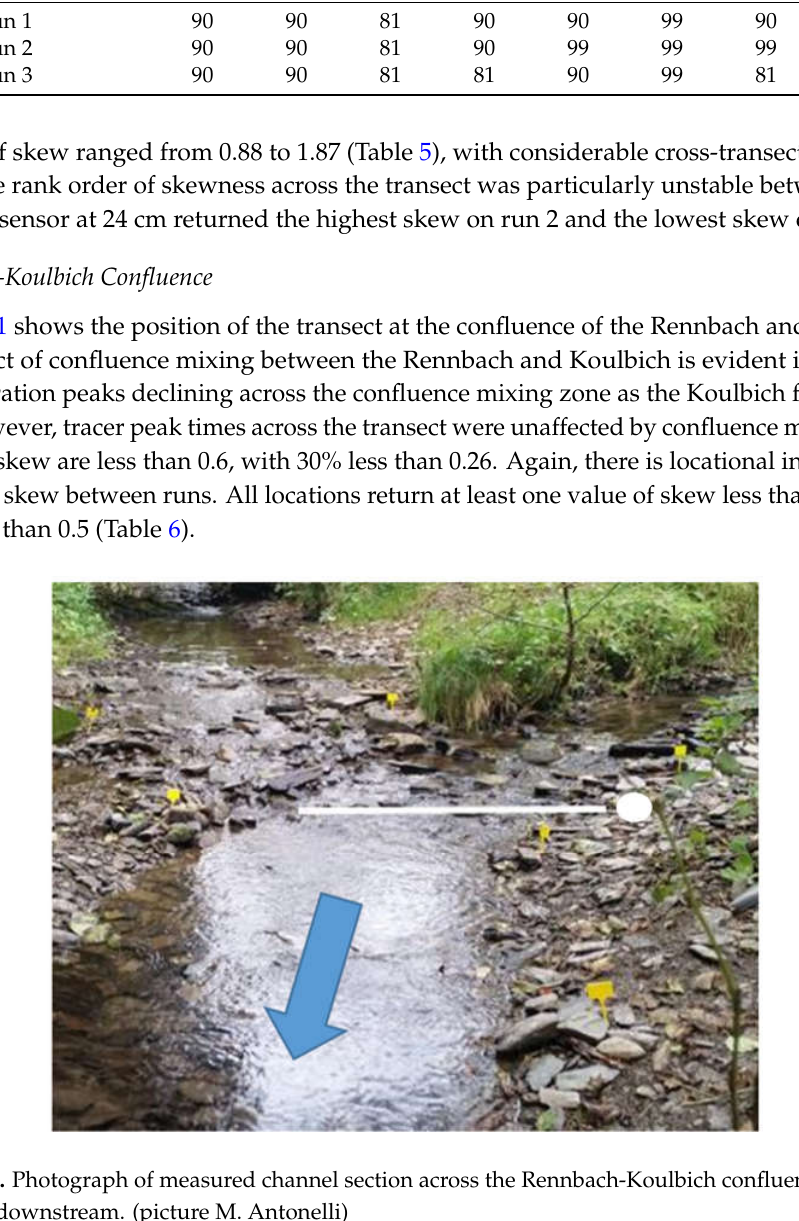
Table 5. Koulbich. Tracer results for skewness and time to peak.